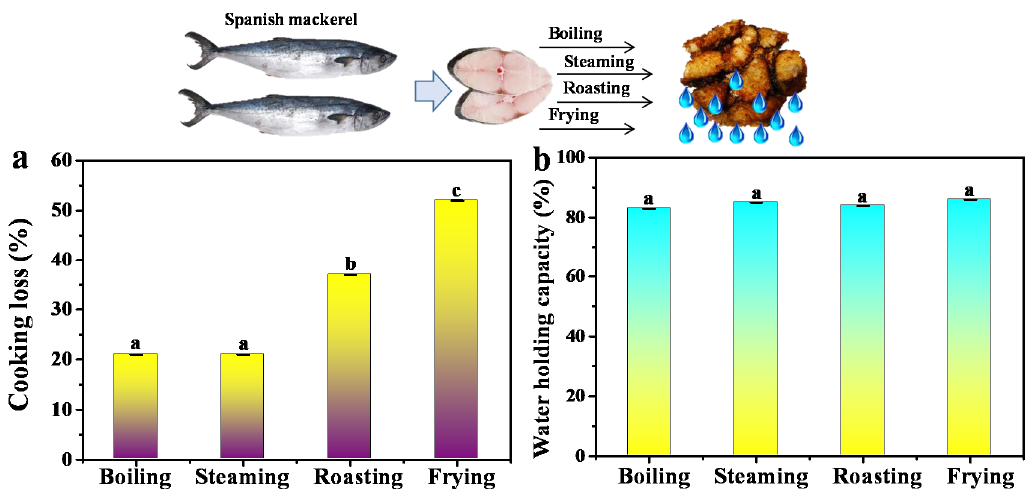
Figure 3. ( a ) Cooking loss of Spanish mackerel after the treatment of boiling, steaming, roasting and frying, ( b ) water holding capacity of Spanish mackerel after the treatment of boiling, steaming, roasting and frying. Different letters indicate significant differences between groups ( p <